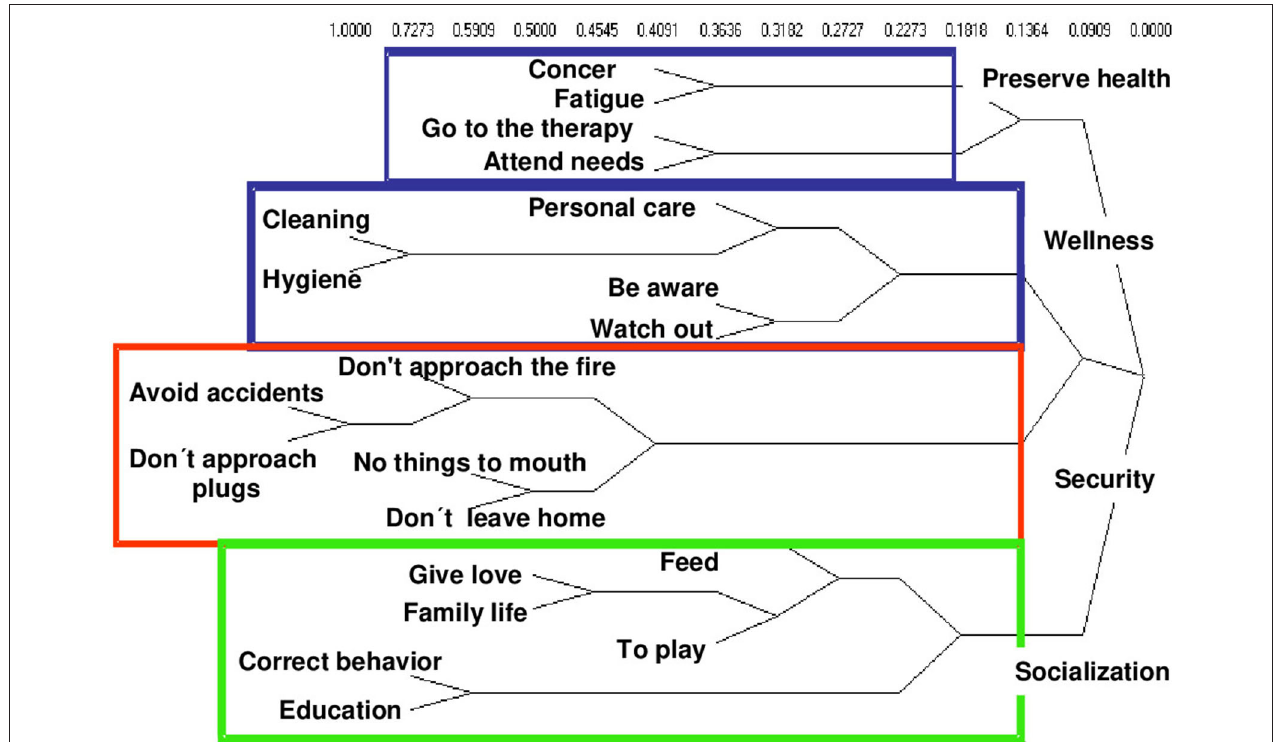
FIGURE 3 | Conceptual dimensions of child care by hierarchical conglomerates. Group 3. Caregivers of children with developmental